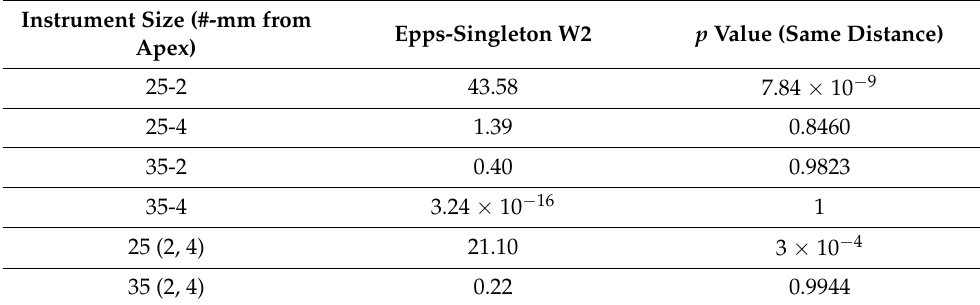
Figure 2. Frequency of cleanness scores registered after analysing the root transversal samples used in this study. In single diameter radar plots (first two rows) teeth 1–10 = PIU, and teeth 11–22 = CI. In pooled diameter radar plots (last row) teeth 1–20 = PIU, and teeth 21–44 = CI. * Statistically significant differences when comparing PIU and CI scores ( p < 0.001, for details see Table 1). Bins = Biomechanical instrumentation (#-mm from apex).